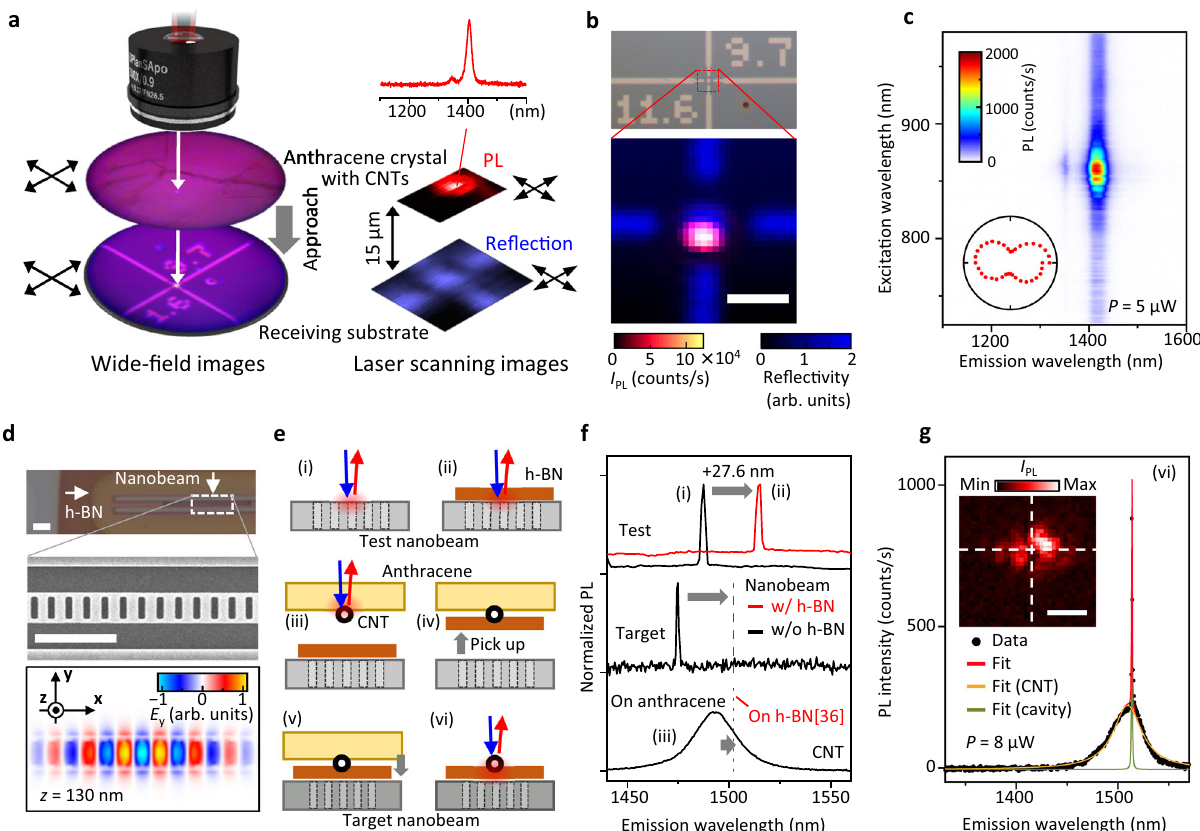
Fig. 4 Demonstration of deterministic transfer of CNTs. a Schematic showing the alignment of a selected CNT and a receiving substrate. Wide- fi eld images and laser scanning images are simultaneously obtained for the stamp and the substrate. b Optical images of the receiving substrate, which is covered by a polystyrene fi lm to suppress exciton quenching (see Fig. 3). Top panel shows a 35 × 65 μ m 2 micrograph, in which the numbers (11,6) are lithographically patterned metal, and represent the chiral index of a CNT to be transferred. Confocal PL image of the transferred (11,6) nanotube (bottom), where integrated PL intensity I PL at 1418 nm and the laser re fl ectivity are superimposed. c PLE map of the transferred CNT. Inset: Polarization dependence of I PL . Data in b and c are taken with excitation power P = 5 μ W. d Optical micrograph of a nanobeam cavity covered with a ~30-nm-thick h-BN fl ake.